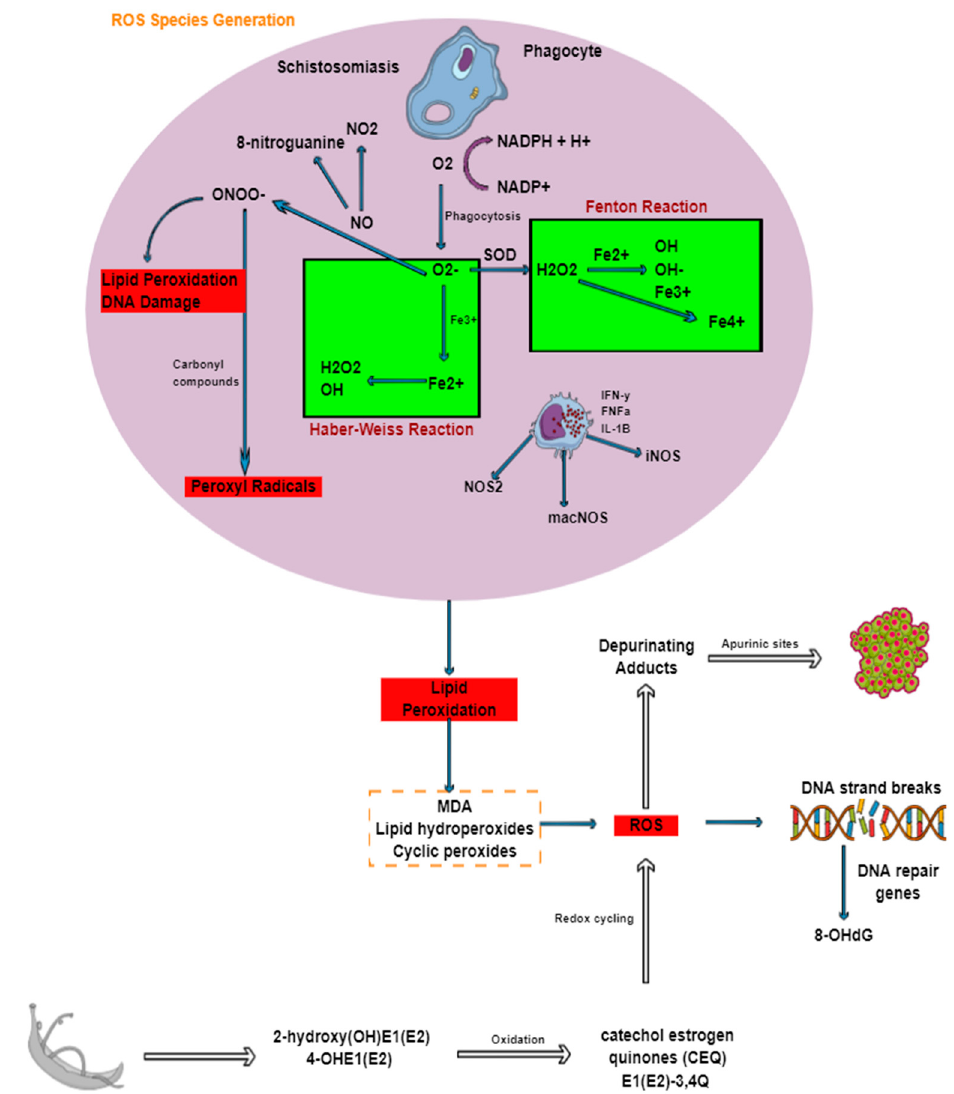
Figure 4. Generation of ROS during schistosomiasis and its association with DNA damage and cancer. Through oxidative or respiratory burst ROS are formed. Nitrosative stress is primarily produced from macrophages and nitric oxide, which reacts with superoxide anion. The production of ROS results in lipid peroxidation, which eventually leads to breaks in DNA strands and subsequently cancer.